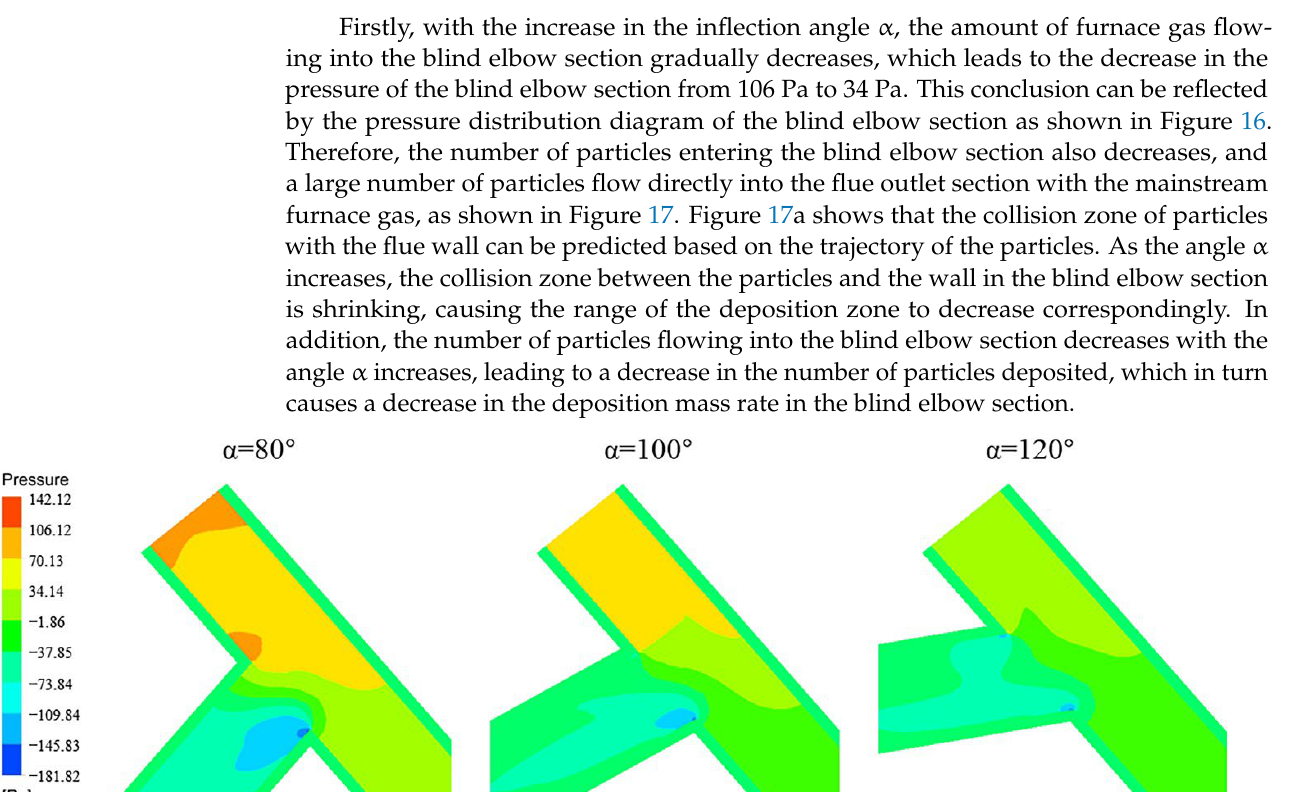
Figure 16. The local pressure distribution in the flue at the different angle α. ( a ) α = 80°; ( b ) α = 100°; ( c ) α = 120°.